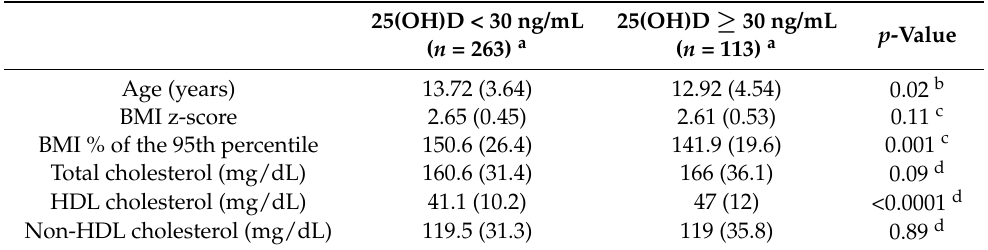
Table 2. Laboratory characteristics in subjects with 25(OH)D < 30 ng/mL and in those with 25(OH)D levels ≥ 30